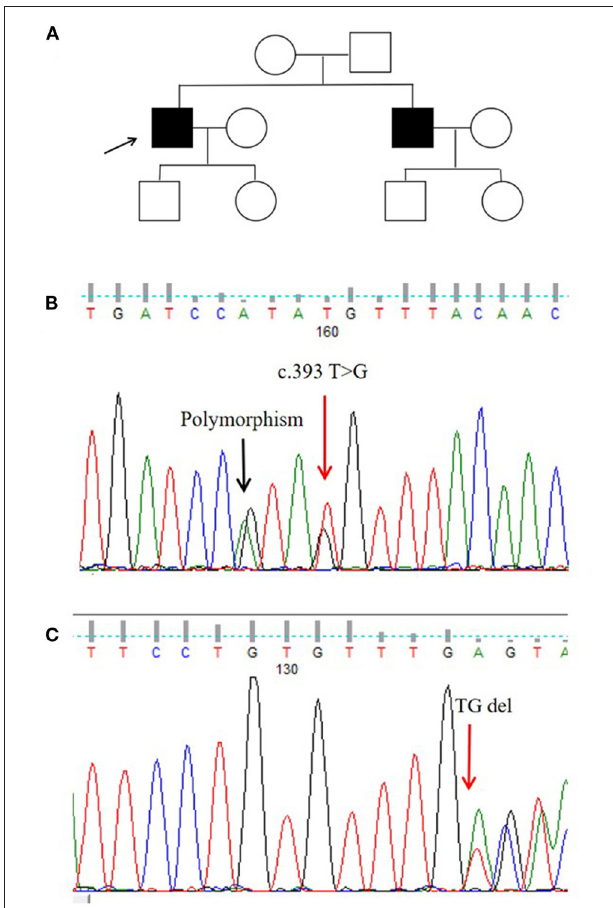
FIGURE 2 | Pedigree map and gene mutation sites. (A) Pedigree of the proband. (B,C) Glycoprotein non-metastatic melanoma protein B (GPNMB) mutations detected in the proband.